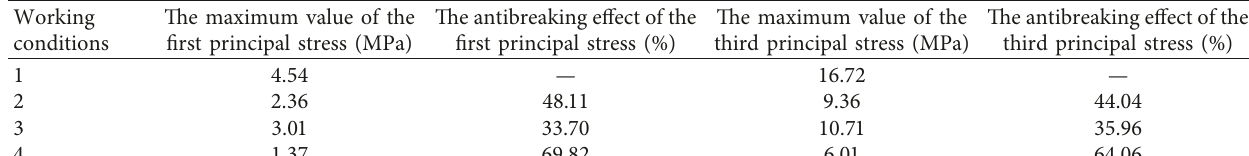
Figure 6: Principal stress. (a) The first principal stress. (b) The third principal stress. Table 5: The antibreaking effect of principal stress.